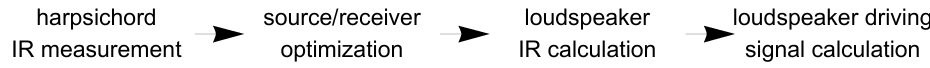
Figure 2. Flow diagram of the proposed method. First, harpsichord Impulse Responses (IR) are measured, then the distribution of loudspeakers and listening points is optimized, and finally, loudspeaker driving signals are